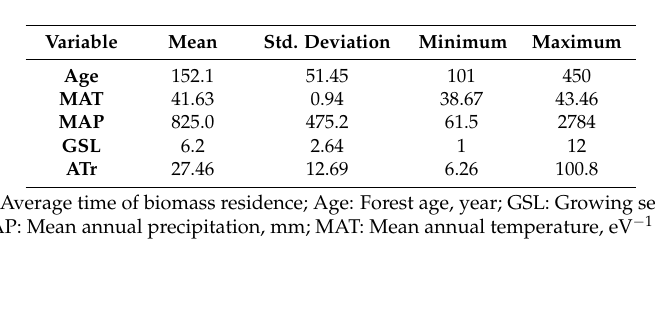
Table 1. Summary statistics for the fitting data.